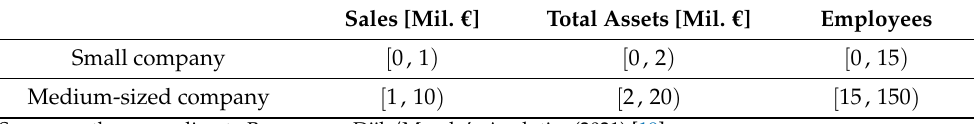
Table 2. The classification of